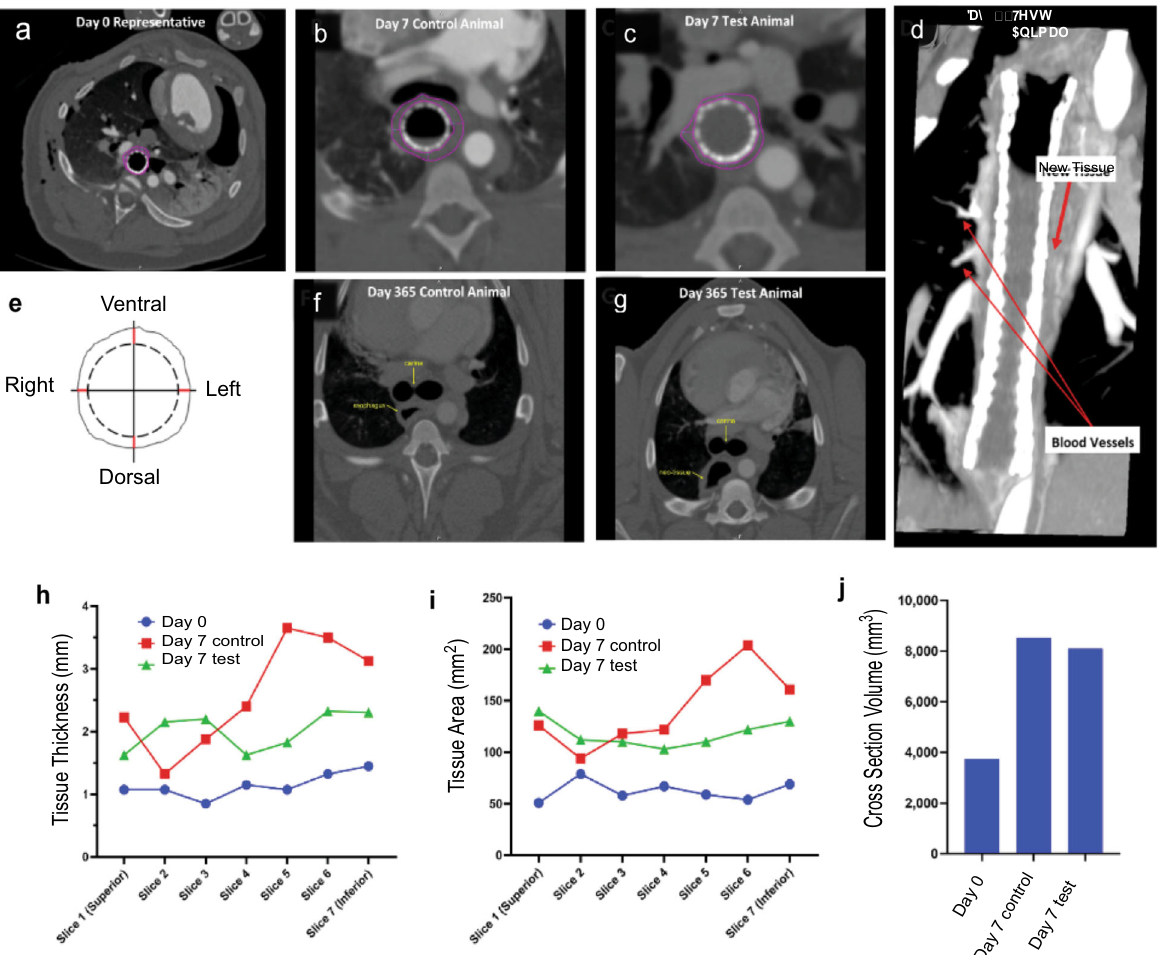
Fig. 3 Analysis of esophageal tissue formation using computed tomography imaging. Test and surgical control animals were evaluated by CT Scan at various timepoints throughout the study with and without the addition of contrast dye ( a – d, f , g ). Vessels sprouting from the aorta to the newly formed tissue were observed at Day 21 via CT Scan with contrast ( d ). Cross-section images were analyzed by Medical Metrics Inc. (Houston, TX) for tissue thickness (mm), tissue area (mm 2 ) and tissue volume (mm 3 ). The averages of each timepoint for each slice was graphed below ( h – j ). It ’ s important to note that the control tissue was a slightly larger area compared to the regenerated tissue